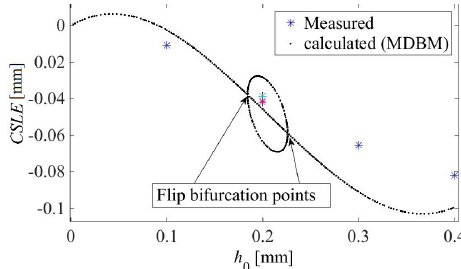
Figure 7. Calculated CSLE function and the mea- sured displacements (blue stars denote the converged solutions; colored stars denote the period doubling characteristics).